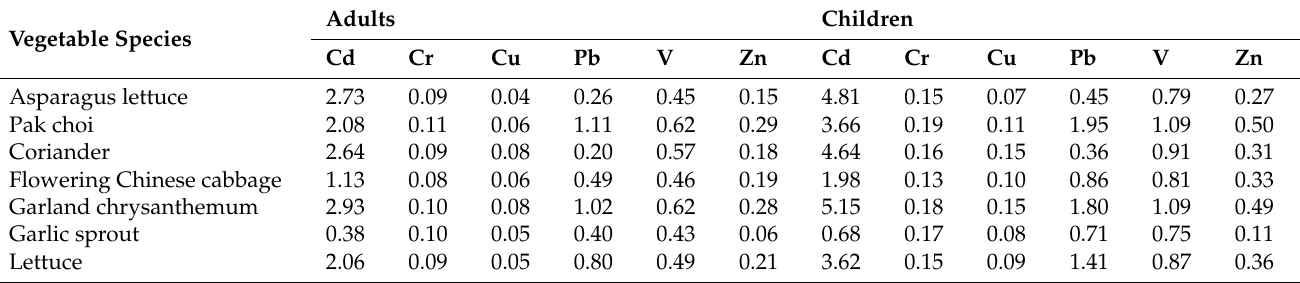
Figure 8. Risk contribution of trace metals to hazard index (HI) of vegetable ingestion for adults and children. Table 2. Non-carcinogenic risk through vegetable ingestion around the V-containing stone coal smelting site for adults and children: 90th percentile of hazard quotient (HQ).